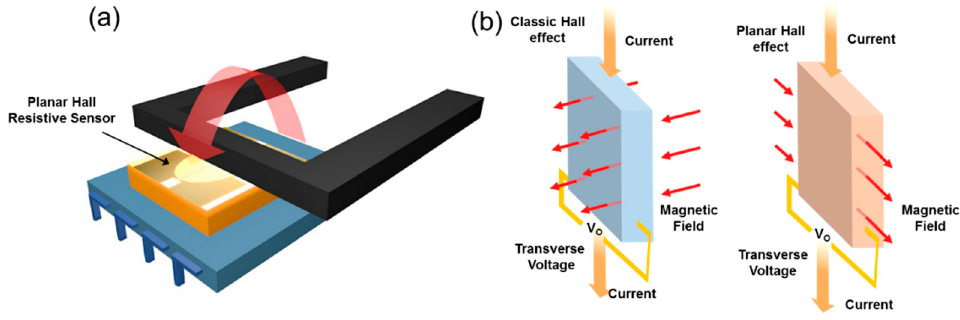
Figure 1. ( a ) Structure of an open-type current sensor and ( b ) mechanism of Planar Hall Resistive Figure 1. ( a )Structureofanopen-typecurrentsensorand( b (PHR) sensor.